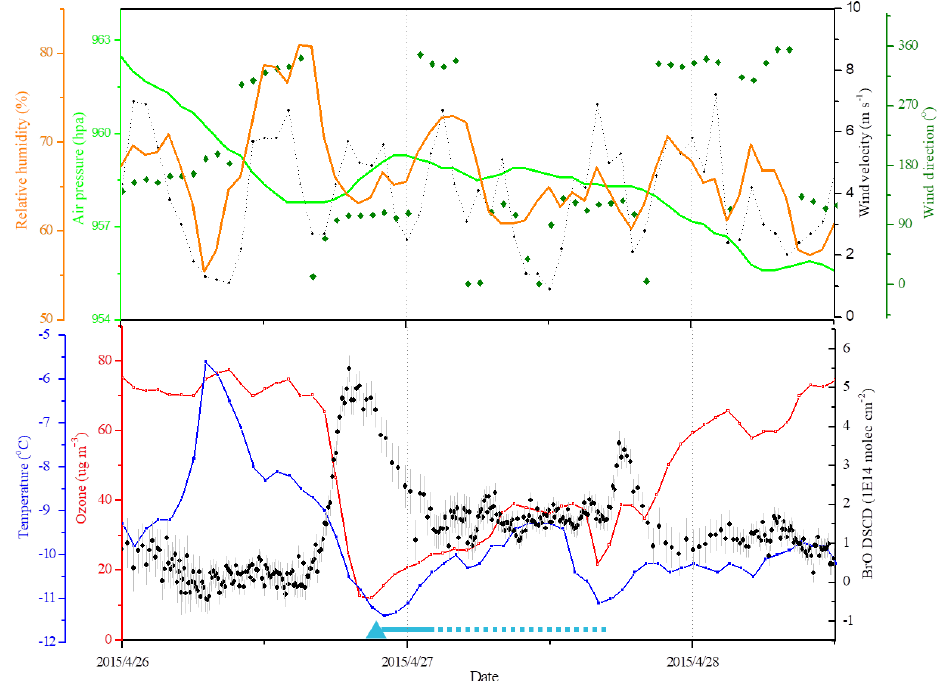
Figure 12. Time series of chemical and meteorological changes during the BrO enhancement event; blue triangles represent the existence of sea ice in Kings